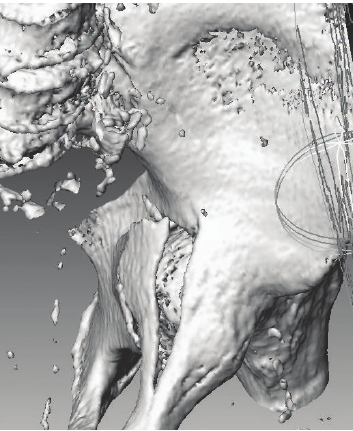
Figure 3: Intrapelvic 3D CT reconstructed view of the right Hip with protrusion of the left femoral head.